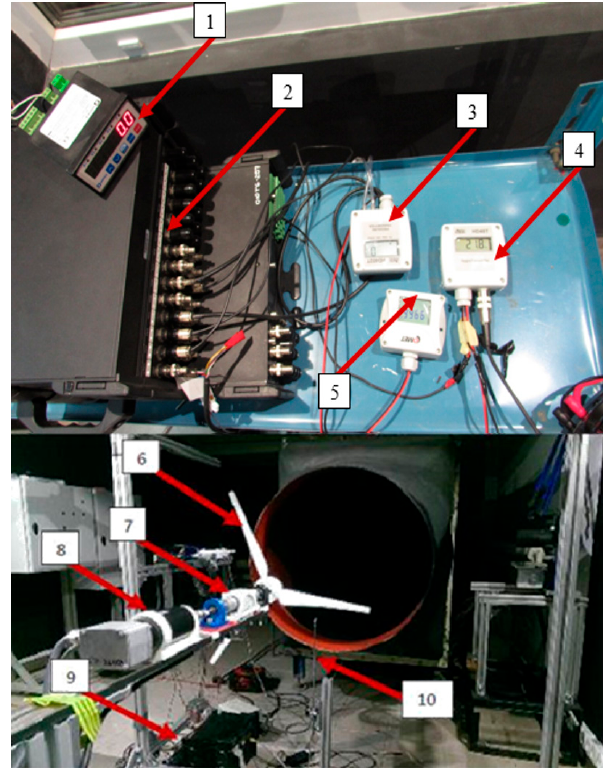
Figure 7. Wind turbine test bench in IMP TUL wind tunnel (system partially disassembled for better visibility).